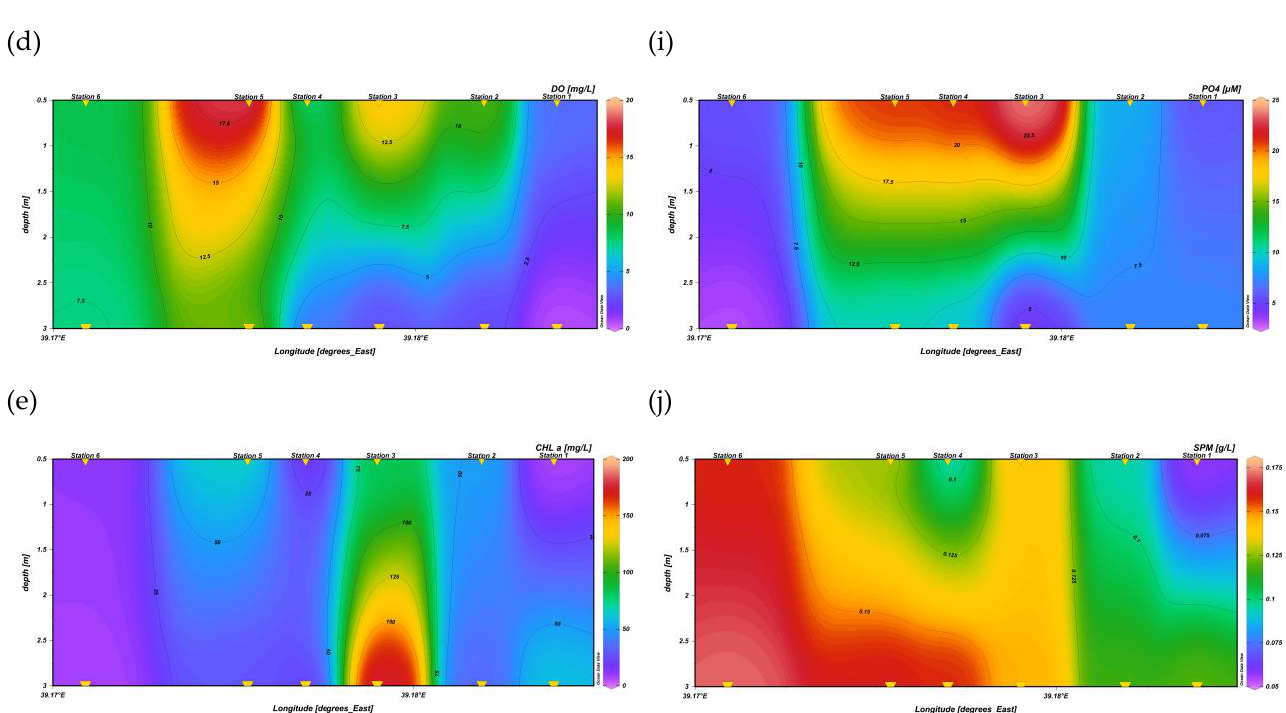
Figure 5. Physical and chemical parameters vertical cross-section along Al-Arbaeen lagoon.